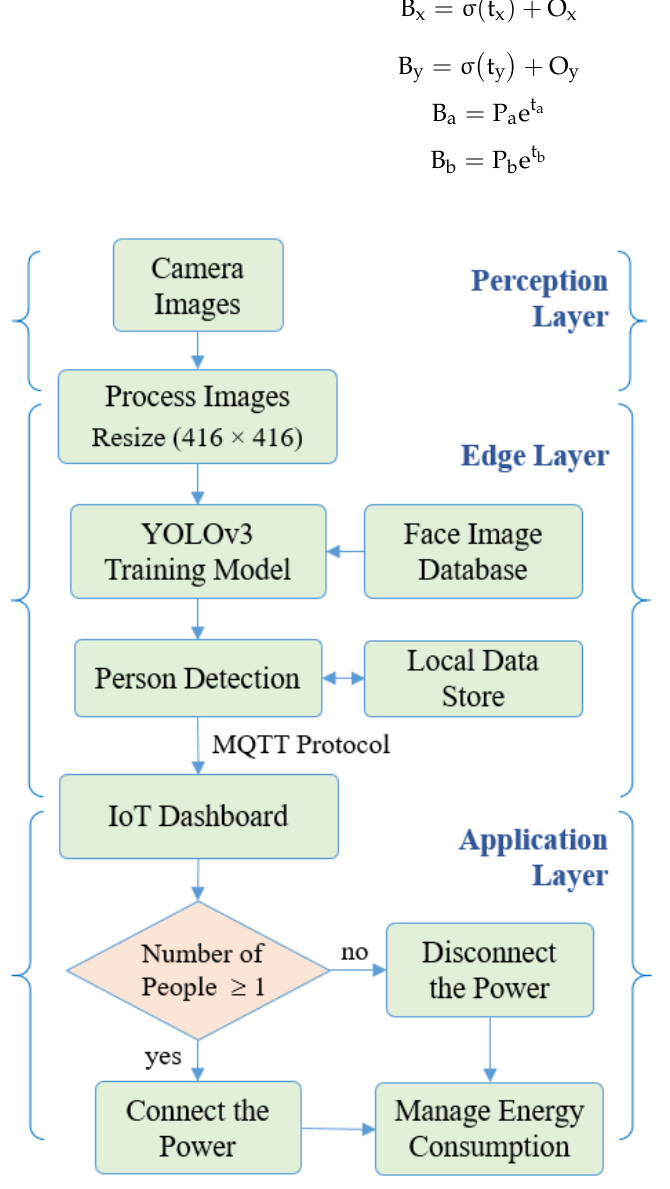
Figure 2. Flowchart for the solution steps of the proposed system.